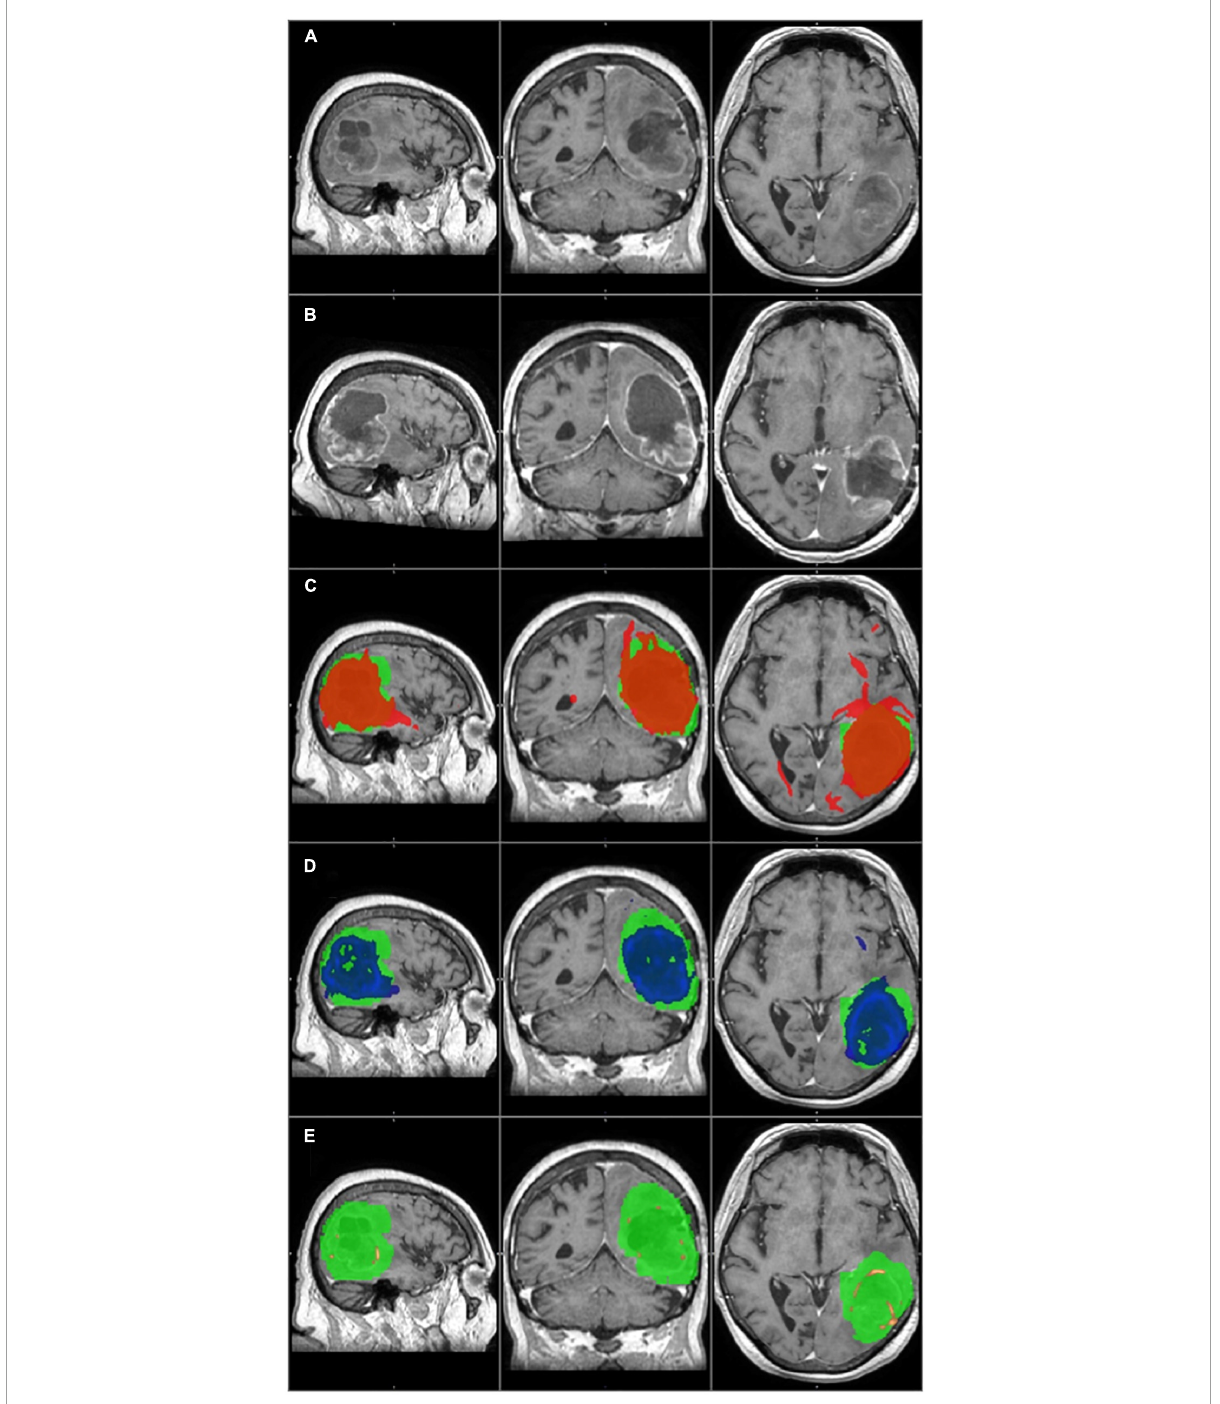
FIGURE2 The primary tumor, the recurrence tumor, and the overlap between the different TCs and the tumor recurrence mask of the representative case of Patient 14 are displayed in this figure. All images are transformed to the MNI152 1 mm space. (A) The preoperative contrast enhanced T1 image. A huge tumor with ring shaped contrast enhancement can be seen in the left temporo-parito-occipital region. (B) The size and the location of the tumor recurrence. (C) The 1% TC (red) is overlapped on the tumor recurrence mask (green). (D) The 5% TC (blue) is overlapped on the tumor recurrence mask (green). (E) The 40% TC (red-yellow) is overlapped on the tumor recurrence mask (green). (C–E) Are on the preoperative T1 images. Although the sensitivity is higher at 1% than at 5%, the specificity is lower due to the greater number of false positive regions. The best overlap can be seen at the 5% threshold level. At 40%, the TC is almost invisible and covers only a small portion of the tumor recurrence mask resulting in high specificity but low